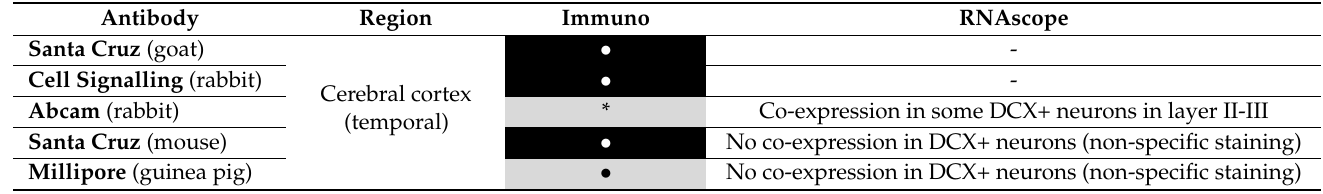
Table 5. Occurrence and quality of staining for DCX in human brain